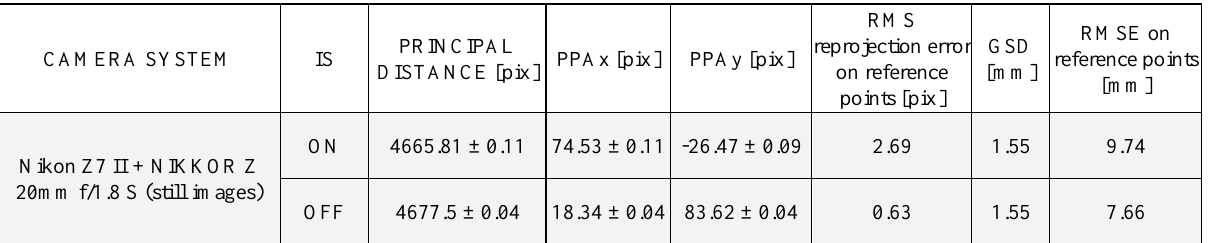
Table 2 . Results from the INDIGO